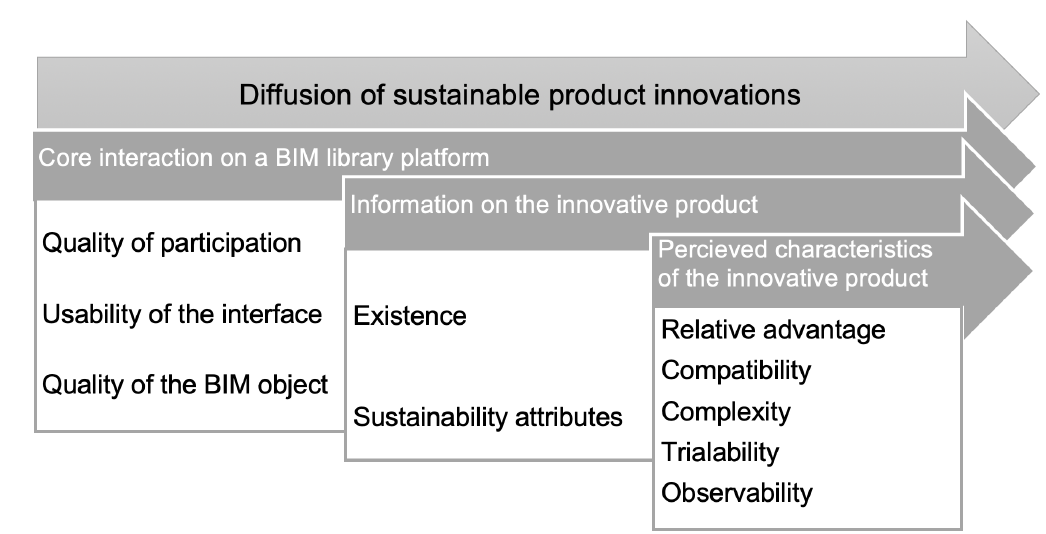
Fig. 6. The role of the BIM library platforms in the diffusion of sustainable innovative products